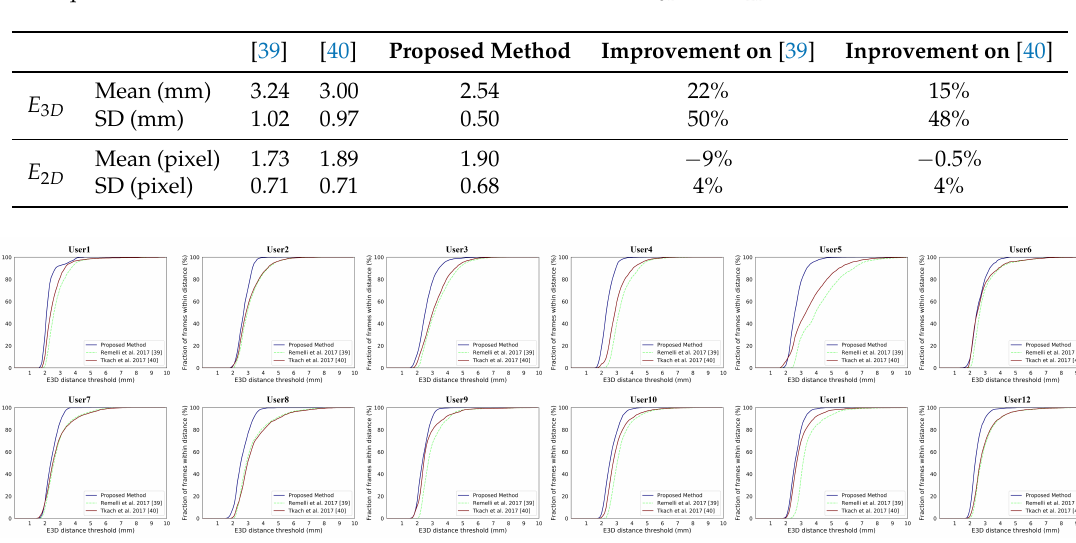
Table 4. The numerical improvements between our system and [39,40] on the Handy/GuessWho sequence. We consider the the mean value and the SD of the E 3 D and E 2 D .